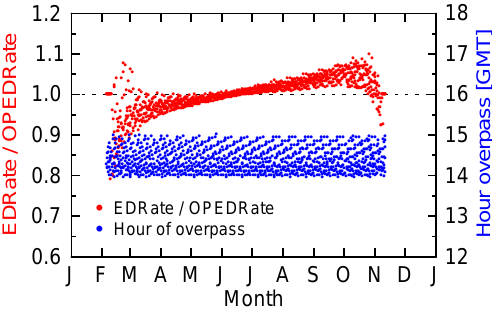
Figure 9. Ratio of EDRate / OPEDRate from the OMI data file (red, left axis) and the hour of the OMI overpass (blue, right axis) derived from the Summit data set. Data were filtered for VZA < 20 ◦ . The ticks on the x axis indicate the start of a given